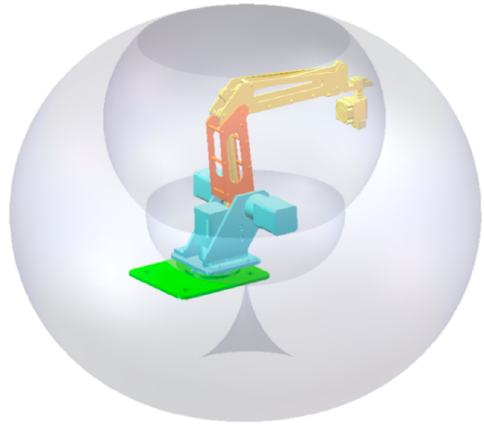
Figure 9. The 3D-printing model of the entire workspace.